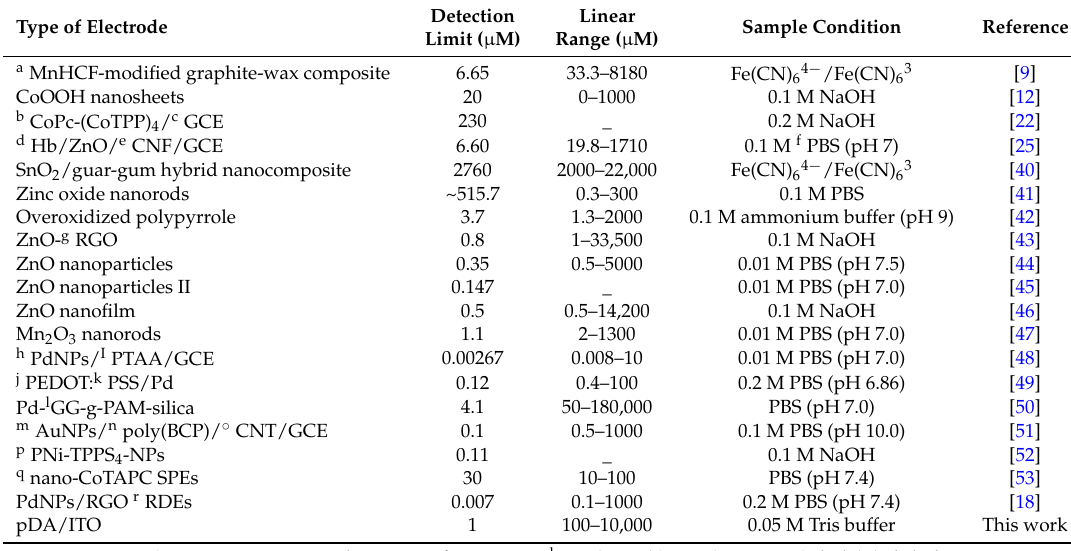
Table 1. Comparison of surface-modified electrodes for HZ